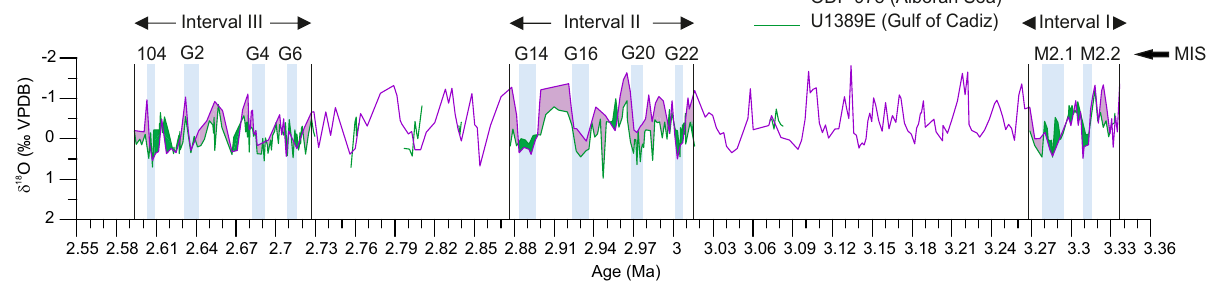
Figure 3. δ 18 O records of IODP Hole U1389E and ODP Hole 978A from 3.33 to 2.60Ma. Intervals I, II, and III with continuous δ 18 O records from both cores are indicated. Marine Isotopic Stages (MISs) have been identified from Lourens et al. (1996) and Khélifi et al. (2014).